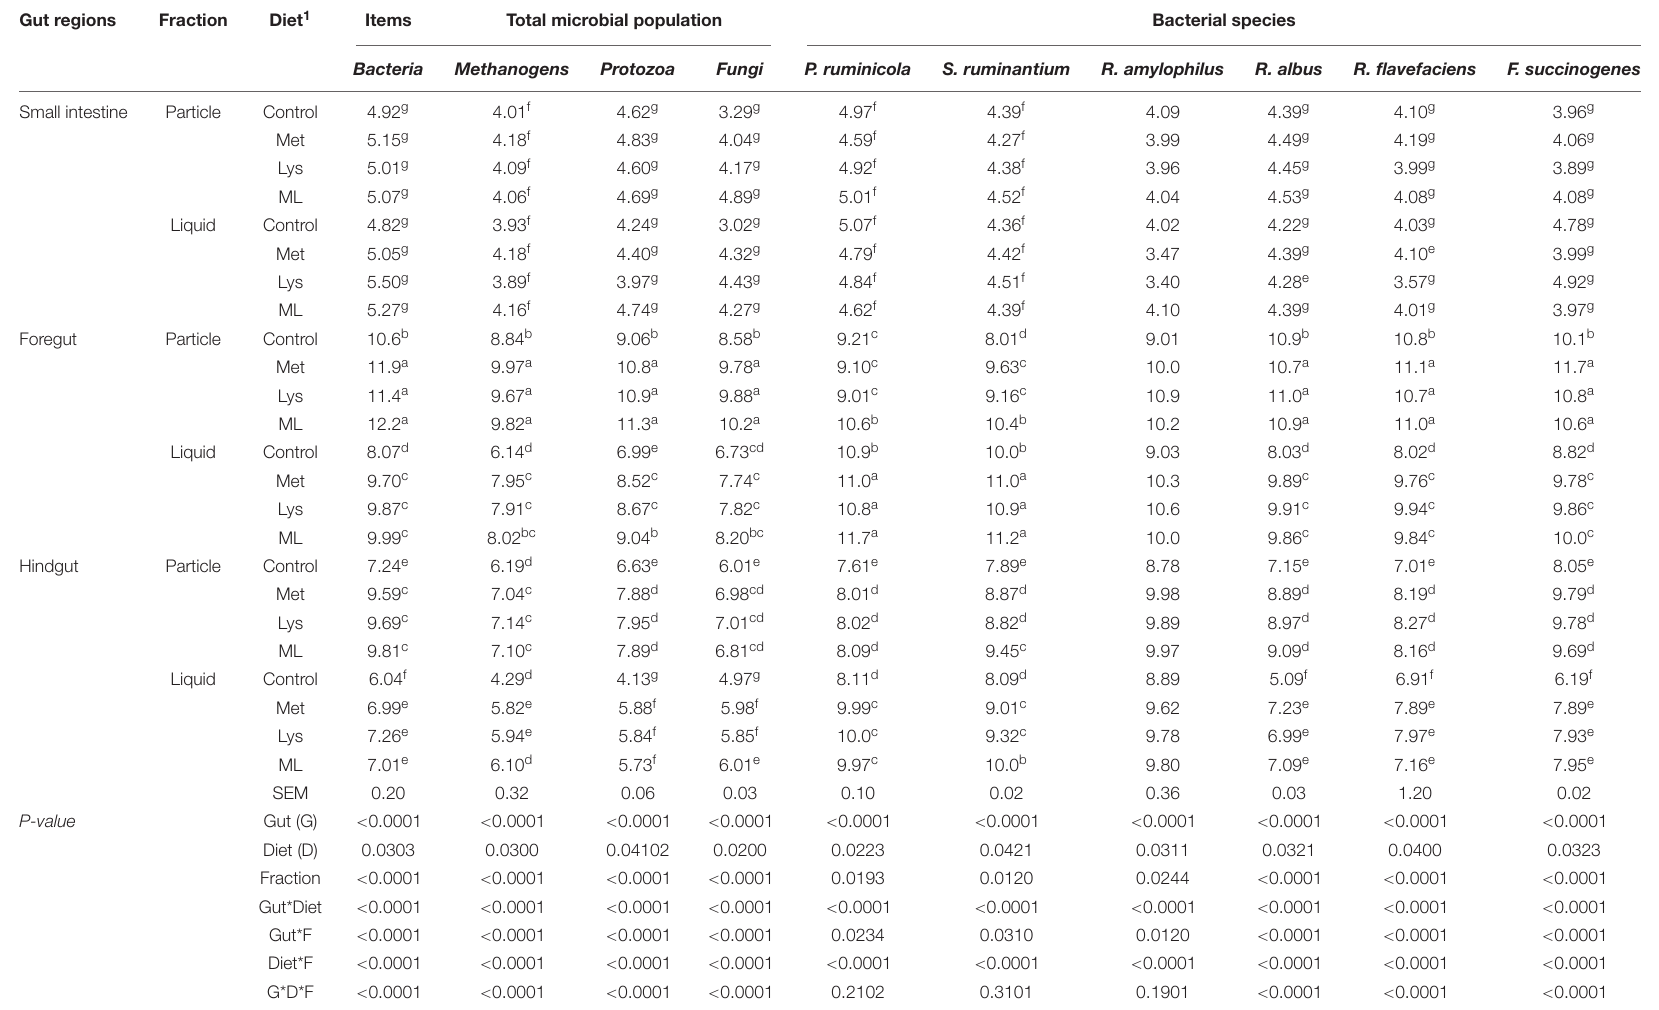
TABLE 6 | Microbiota 2 in different gut regions of goats supplemented with amino acid. Gut regions Fraction Diet 1 Items Total microbial population Bacterial species Bacteria Methanogens Small intestine